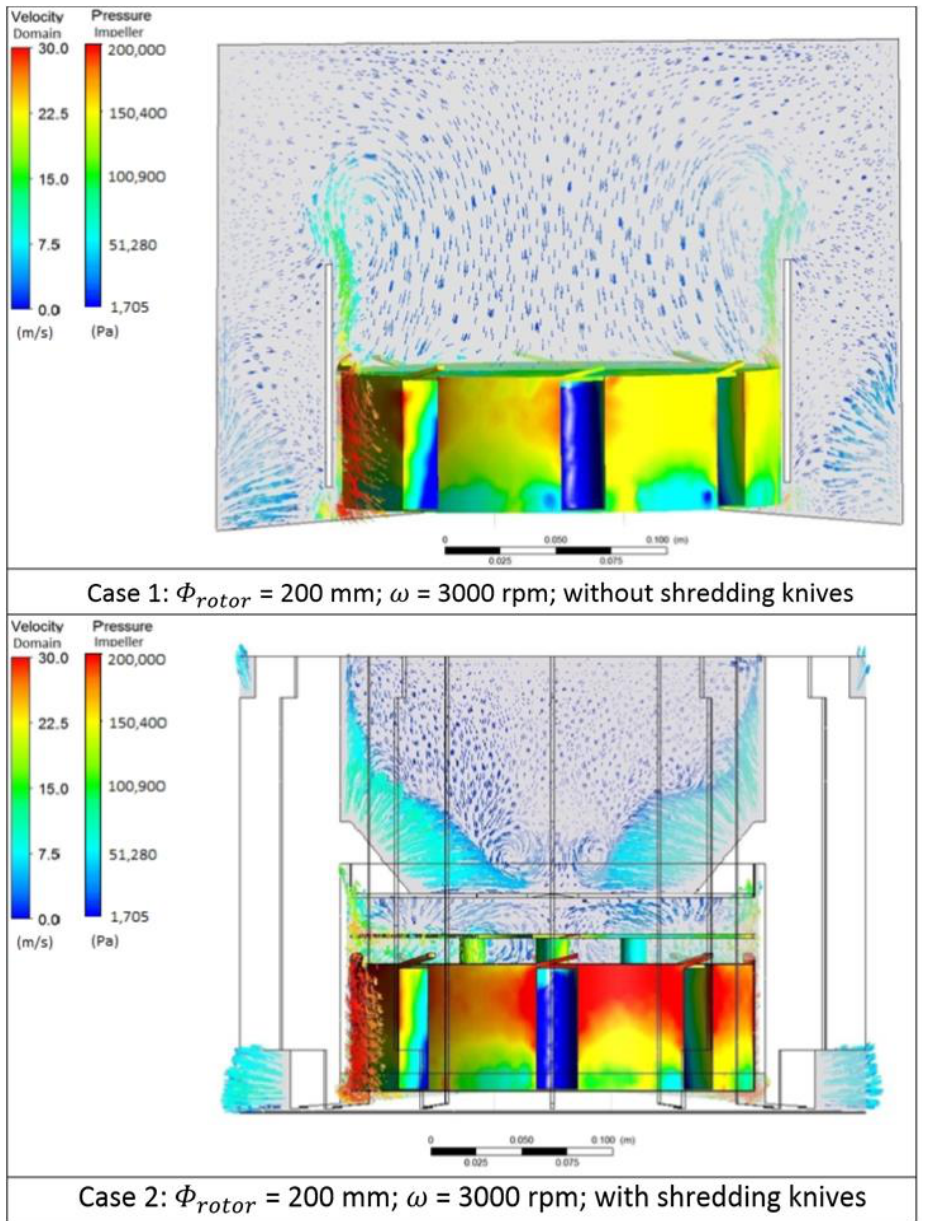
Figure 5. Comparison of pressure fields and speed fields in both variants of the Figure 5 . Comparison of pressure fields and speed fields in both variants of the device.